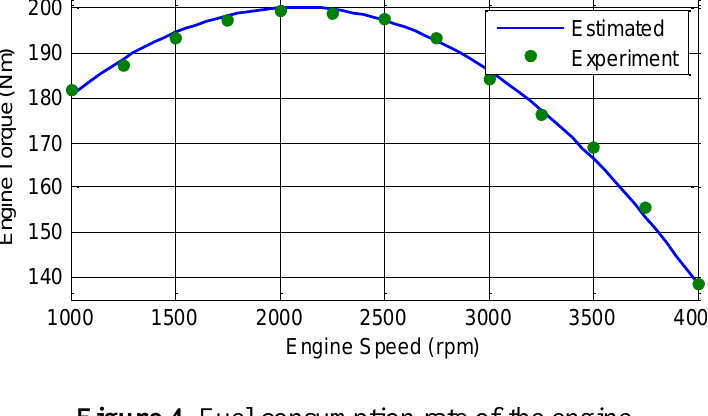
Figure 3. Maximum available torque of the engine.